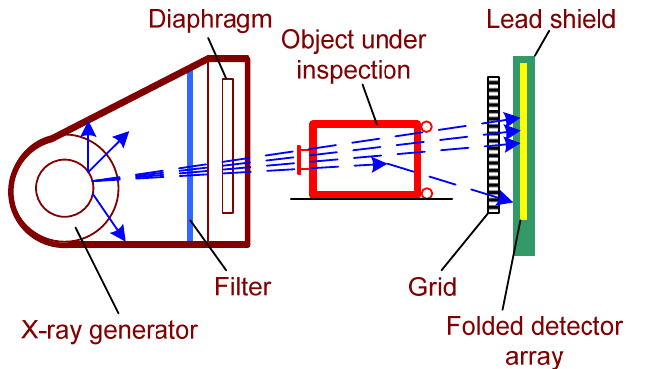
Figure 1. Schematic of a standard projection radiography setup used for non-intrusive inspection of a large-sized item.